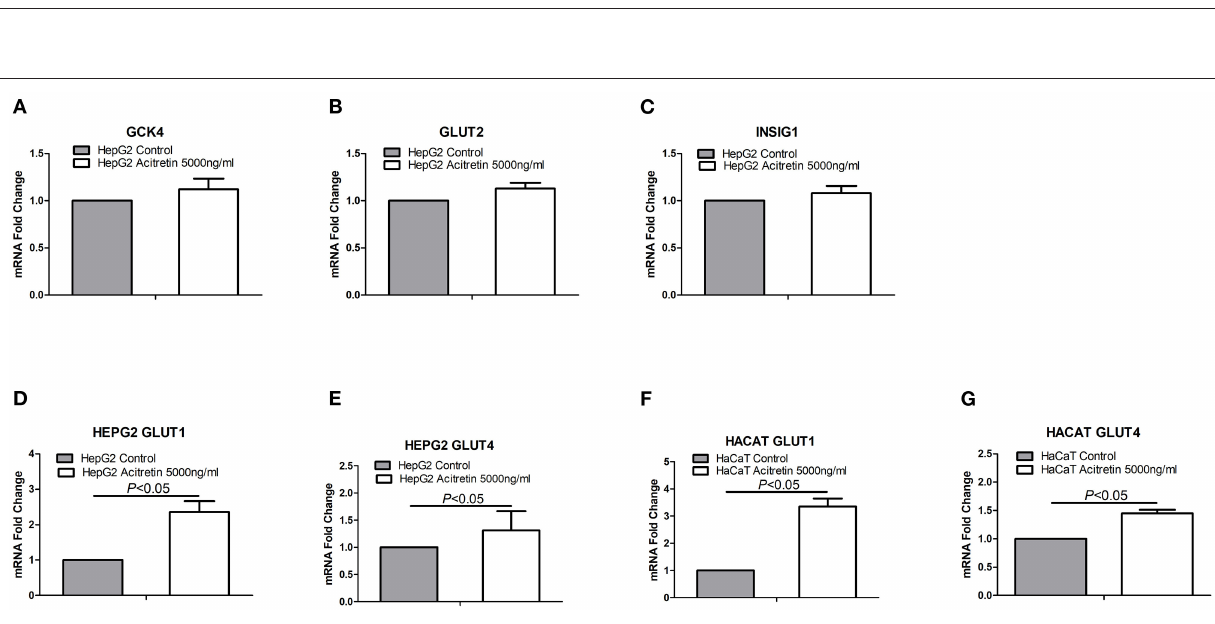
FIGURE 3 | The expression of genes in HaCaT and HepG2 cells when treated with acitretin. Legend: (A–C) the transcript level expression of GCK4, GLUT2 and INSIG1 genes in HepG2 cells with or without the incubation of acitretin 5000ng/ml; (D,E) the GLUT1 and GLUT4 genes expression in HepG2 cells with or without acitretin incubation; (F,G) the GLUT1 and GLUT4 genes expression in HaCaT cells with or without acitretin